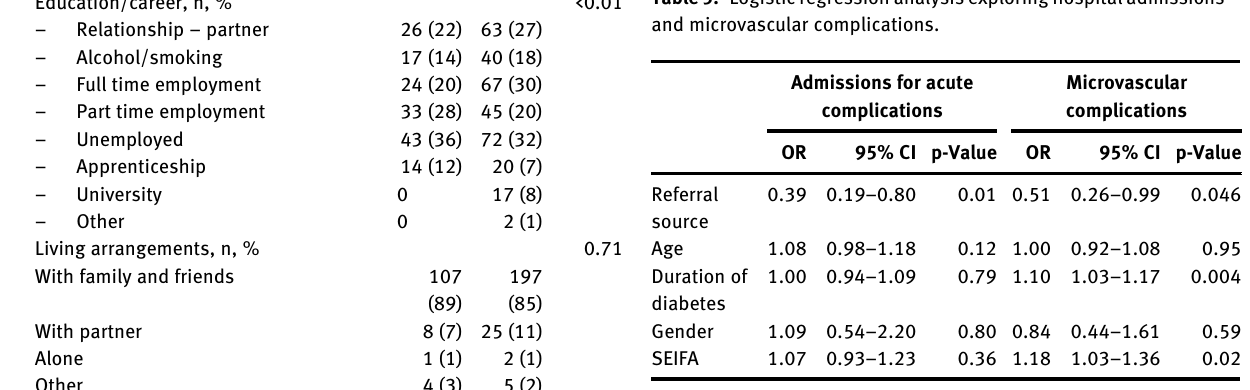
Table 3 describes the clinic attendances for medical and allied health reviews. More patients in the ERG (99%)